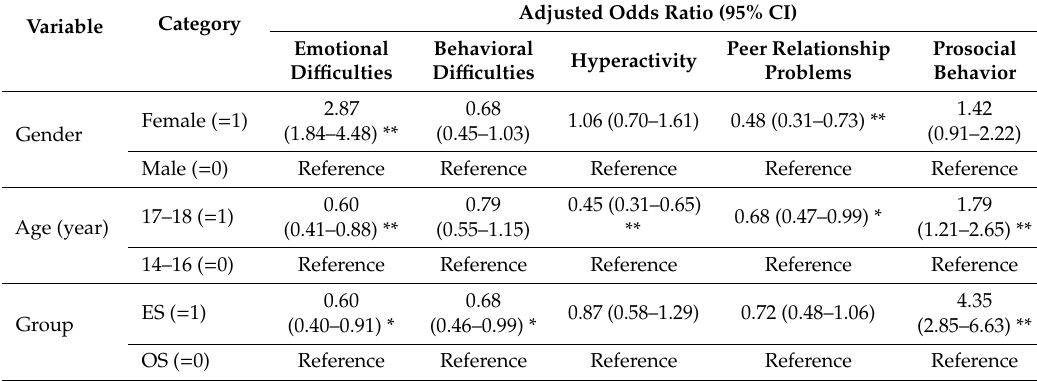
Table 3. Factors influencing the occurrence of behavior problems and prosocial